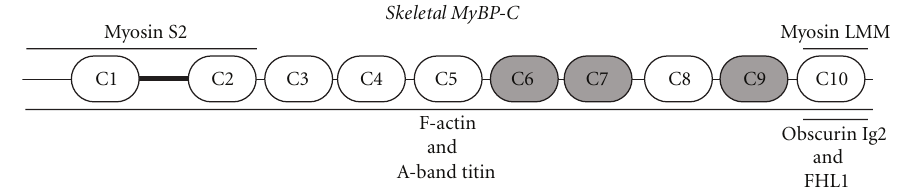
Figure 3: Schematic representation of the core structure of the skeletal isoforms of MyBP-C, depicting their identified binding partners. For ease of representation, the three novel insertions present in MyBP-C slow are not included in the schematic (for detailed description, please see Figure 1 and [12]). Immunoglobulin and fibronectin type III domains are presented as white and grey ovals, respectively. The M-motif is shown as a dark black line flanked by domains C1 and C2. Ligands for skeletal MyBP-C are denoted at their sites of interaction. Notably, obscurin and FHL1 are specific binding partners of v1, since their interactions depend on the presence of the novel COOH-terminal insertion, which is exclusively carried by v1, in addition to the C10